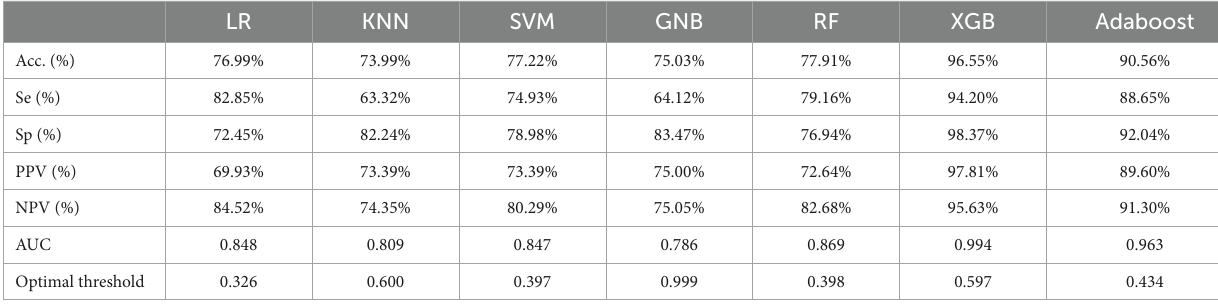
TABLE 8 Performance of classifier implementation on task 4.